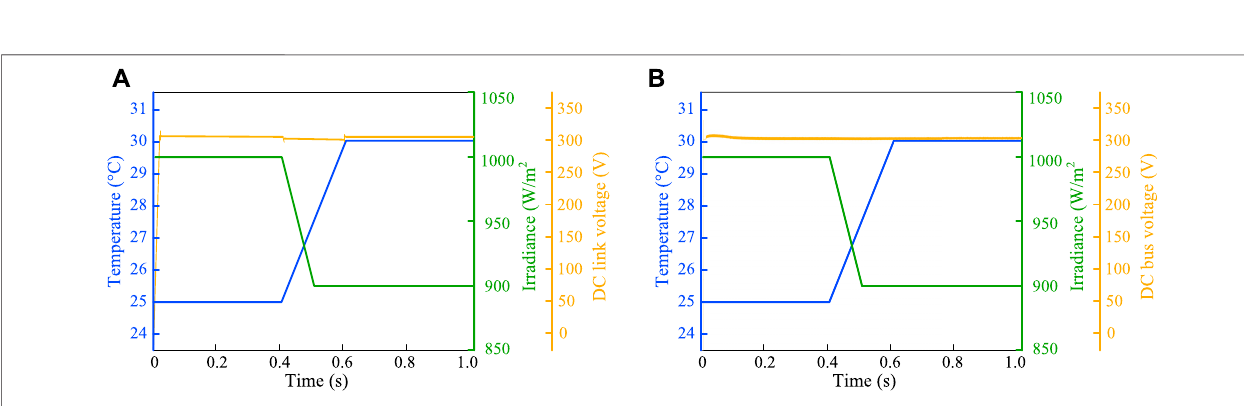
FIGURE 3 | (A) DC-link voltage used for the control of MPPT, (B) Stable DC bus voltage over the variation of temperature and irradiance.